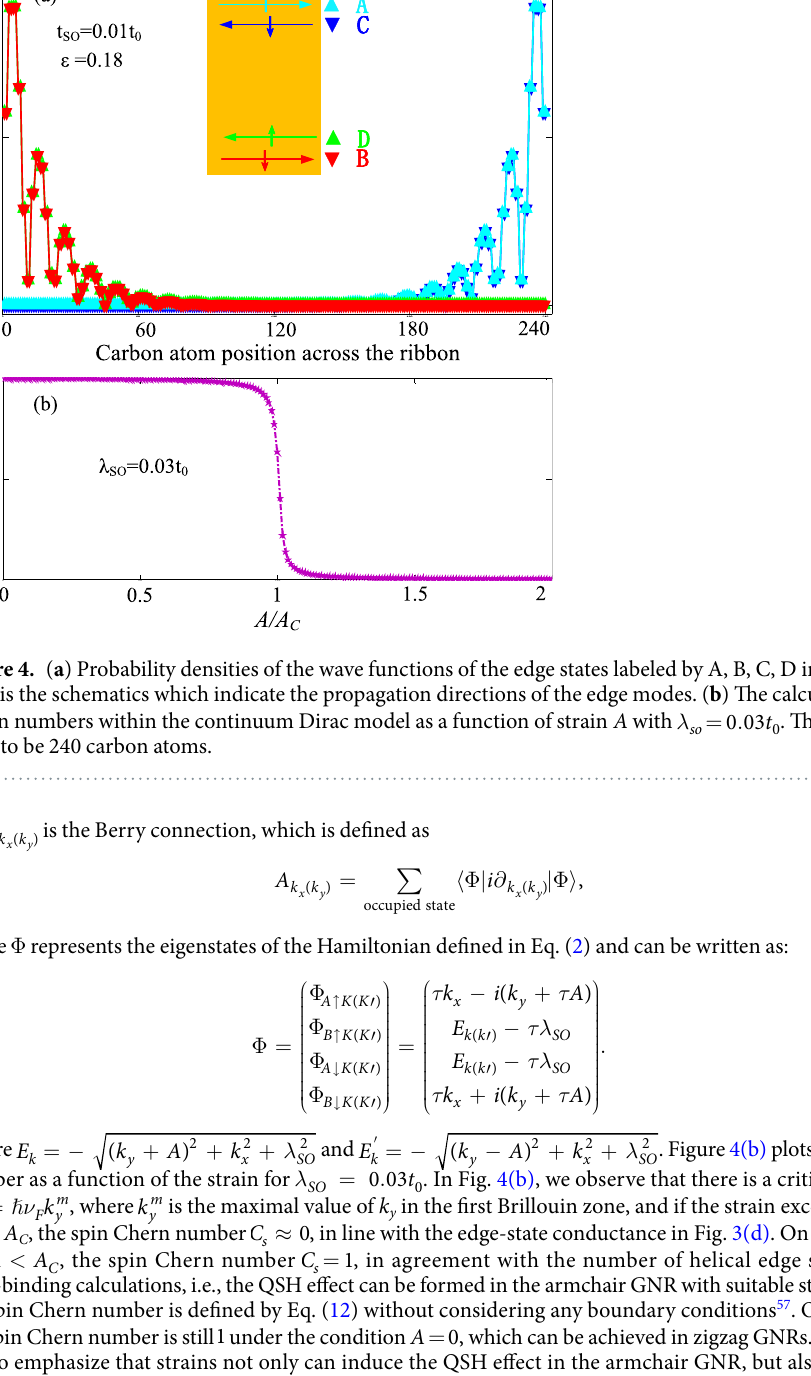
Where λ = − 2 . Figure 4(b) plots the spin Chern number as a function of the strain for λ = . t 0 03 . In Fig. 4(b), we observe that there is a critical strain value SO 0 ym  , where k ym is the maximal value of k ν = A k y in the first Brillouin zone, and if the strain exceeds the critical C F value A C , the spin Chern number ≈ C 0 , in line with the edge-state conductance in Fig. 3(d). On the other hand, s , the spin Chern number = C 1 , in agreement with the number of helical edge states from the for < A A C s tight-binding calculations, i.e., the QSH effect can be formed in the armchair GNR with suitable strains. Note that the spin Chern number is defined by Eq. (12) without considering any boundary conditions 57 . One can see that the spin Chern number is still 1 under the condition A = 0, which can be achieved in zigzag GNRs. Here we would like to emphasize that strains not only can induce the QSH effect in the armchair GNR, but also can achieve a quantum phase transition from the QSH phase to a trivial insulator phase. Usually, the QSH state of matter is considered to be protected by the TR symmetry. But QSH-like phases in sys- tems where the TR symmetry is broken have also been suggested 17 . It was found that the QSH-like state appears in a zigzag GNR with the combined effects of intrinsic SOC, Rashba spin-orbit coupling and an exchange field. Here we further consider the effect of strains on such QSH-like states in a zigzag GNR. From Fig. 5(a), one can easily distin- guish the edge states from the bulk states. Due to the Rashba SOC, s z is not conserved and the spins of the edge states can be rotated to canted orientations. Therefore, we compute the spin polarization = 〈 |∑ (where m is the m th band, i and j are the lattice site indices, and = j x y z , , ) to obtain information about the spin states, and then label the spin directions with the small arrows in Fig. 5(a). Through analysis on the spatial distribution of the wave functions, we find that the spin-textured edge states can be divided into two regions at low energies, and regardless of the spin-texture regions, the edge states from the bands labeled with red and green (blue and cyan) lines are mainly located on the lower (upper) boundary. However, the spin textures are significantly different in these two